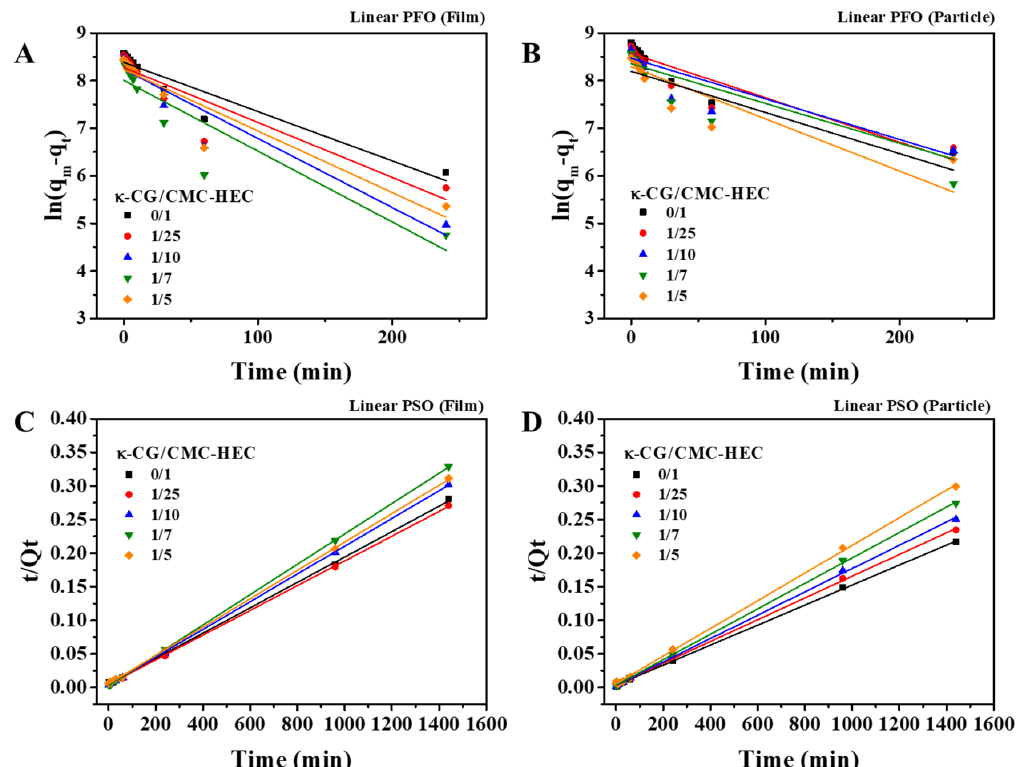
Figure 7. Fitting of the experimental absorption data in deionized water (pH 7) at 25 °C with the ( A , B ) linearized PFO and ( C , D ) PSO kinetic models.